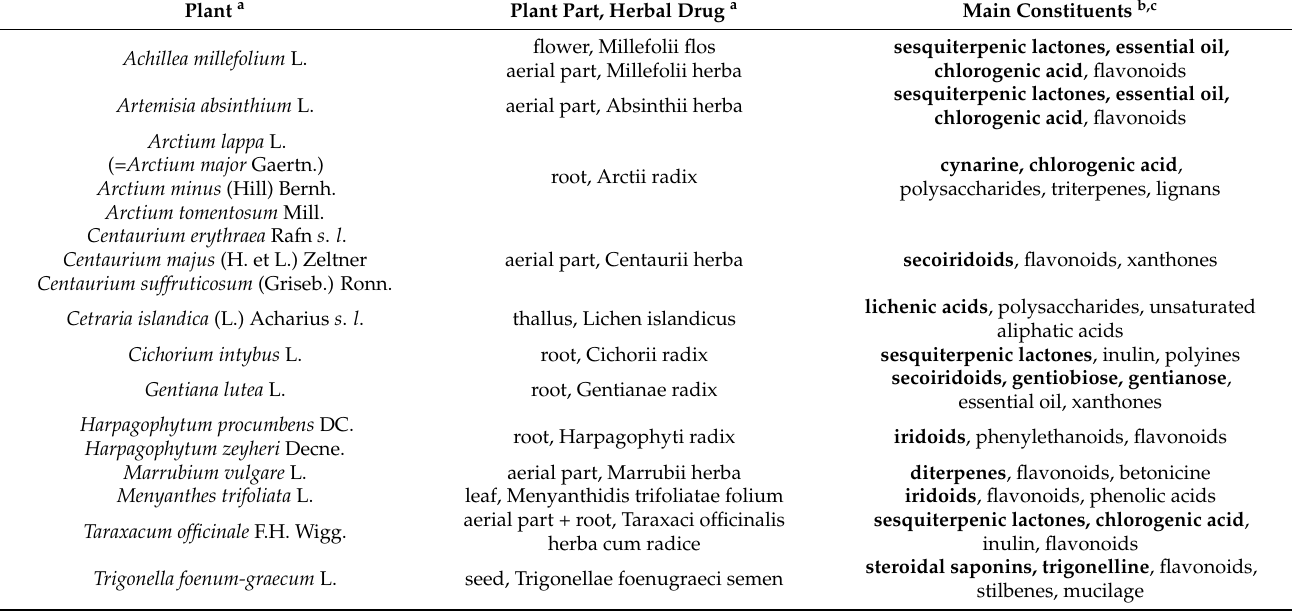
Table 2. Herbal drugs used for temporary loss of appetite treatment